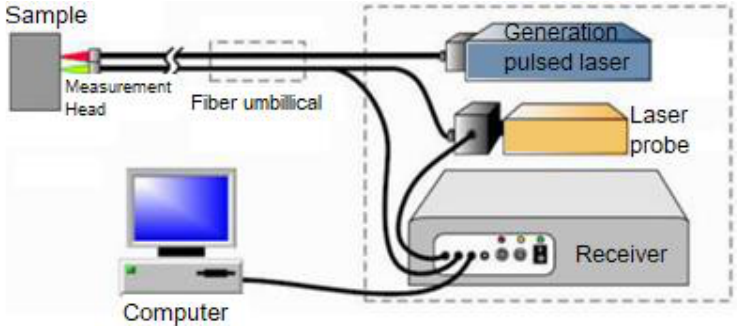
Figure 13. LUT system, adapted from [31].